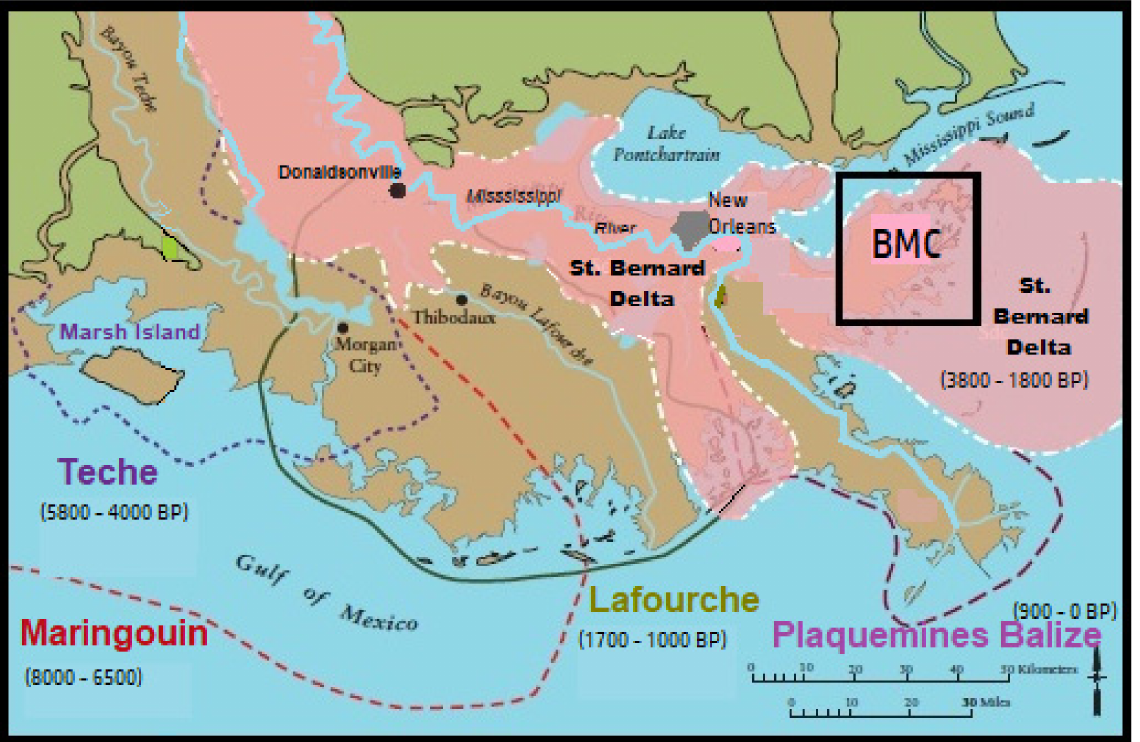
Figure 5. St. Bernard sub-delta at its maximum extent about 1.8 ka with outlines of other Holocene delta lobes and approximate times of advancement (modified from Heinrich et al.